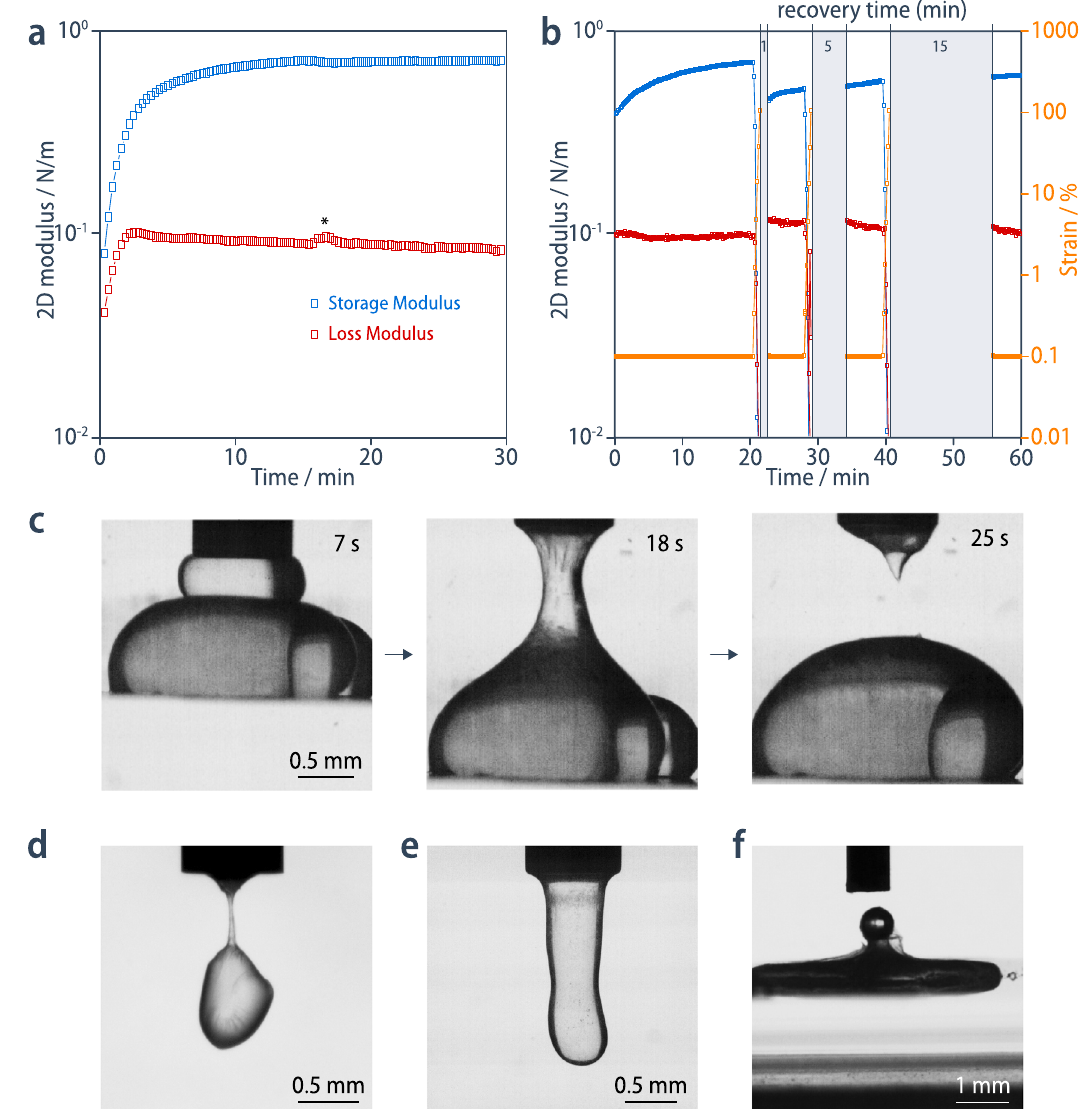
Fig. 4 Self-healing and reshaping of the nanoskin. a Interfacial rheology shows the evolution of the storage and loss moduli with the formation of the nanoskin (the asterisk indicates an experimental artefact). b The self-healing behavior of the nanoskin is followed by interfacial rheology. The nanoskin is ruptured upon a large increase in strain and is left to recover by applying a zero strain; the recovery increases with longer healing time (1, 5, 15 min). c A time-sequence of snapshots showing the initial resistance of two droplets to coalescence; subsequent coalescence under compression leads to the creation of a channel between the needle and the droplet; and the breakage of the channel upon withdrawal of the needle (Supplementary Movie 5). d Irregularly shaped droplet suspended by a channel with an extremely narrow cross-section. e Droplet with an elongated tubular shape. f Collapsed droplet containing a gas bubble, which gets trapped by the